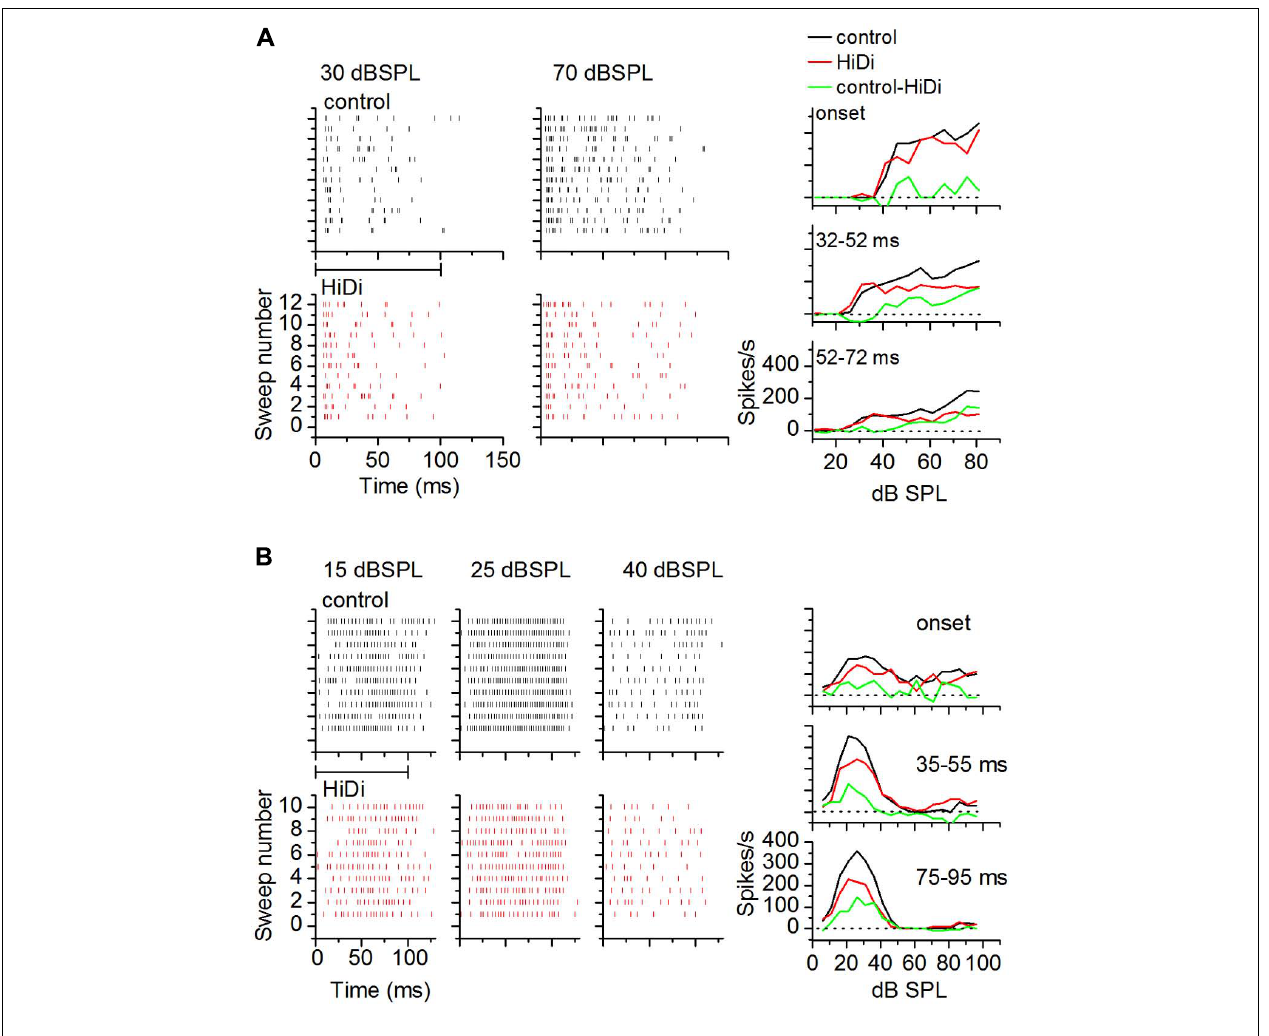
FIGURE 7 | Local circuits in vivo show temporal variations. (A,B) Examples of HiDi effects on two neurons. (A) At 30 dB SPL, which was 15 dB above threshold for this neuron, HiDi did not affect spiking. At 70 dB SPL, HiDi reduced spiking, but mainly at later times during the tone. Rate-level functions plotted in different time windows during the tone for this cell (right column) show little effect of HiDi immediately following tone onset, but a